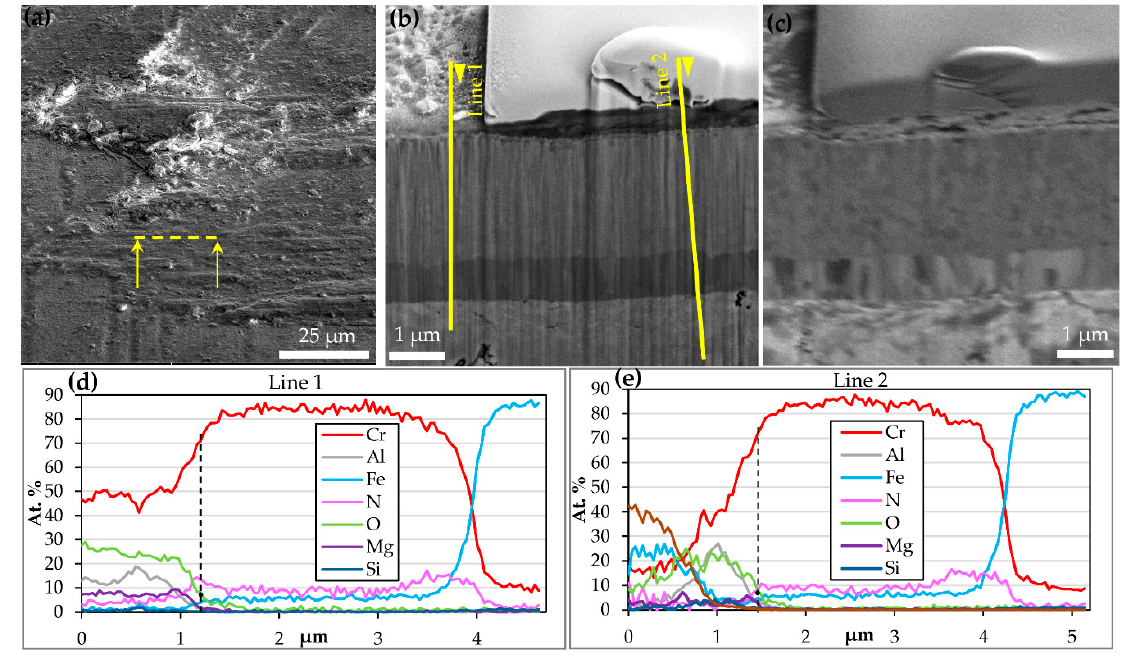
Figure 5. FIB analysis of the CrN ‐ R pin sample with aluminum built ‐ up after DS 20 experiment, ( a ) secondary electron image, line and arrows indicate FIB milling line and the direction of cross section observation, ( b ) cross ‐ sectional secondary electron image, ( c ) cross ‐ sectional ion induced secondary electron image, ( d ) and ( e ) chemical composition obtained by EDS analysis conducted on cross section along lines drawn in the image (b).